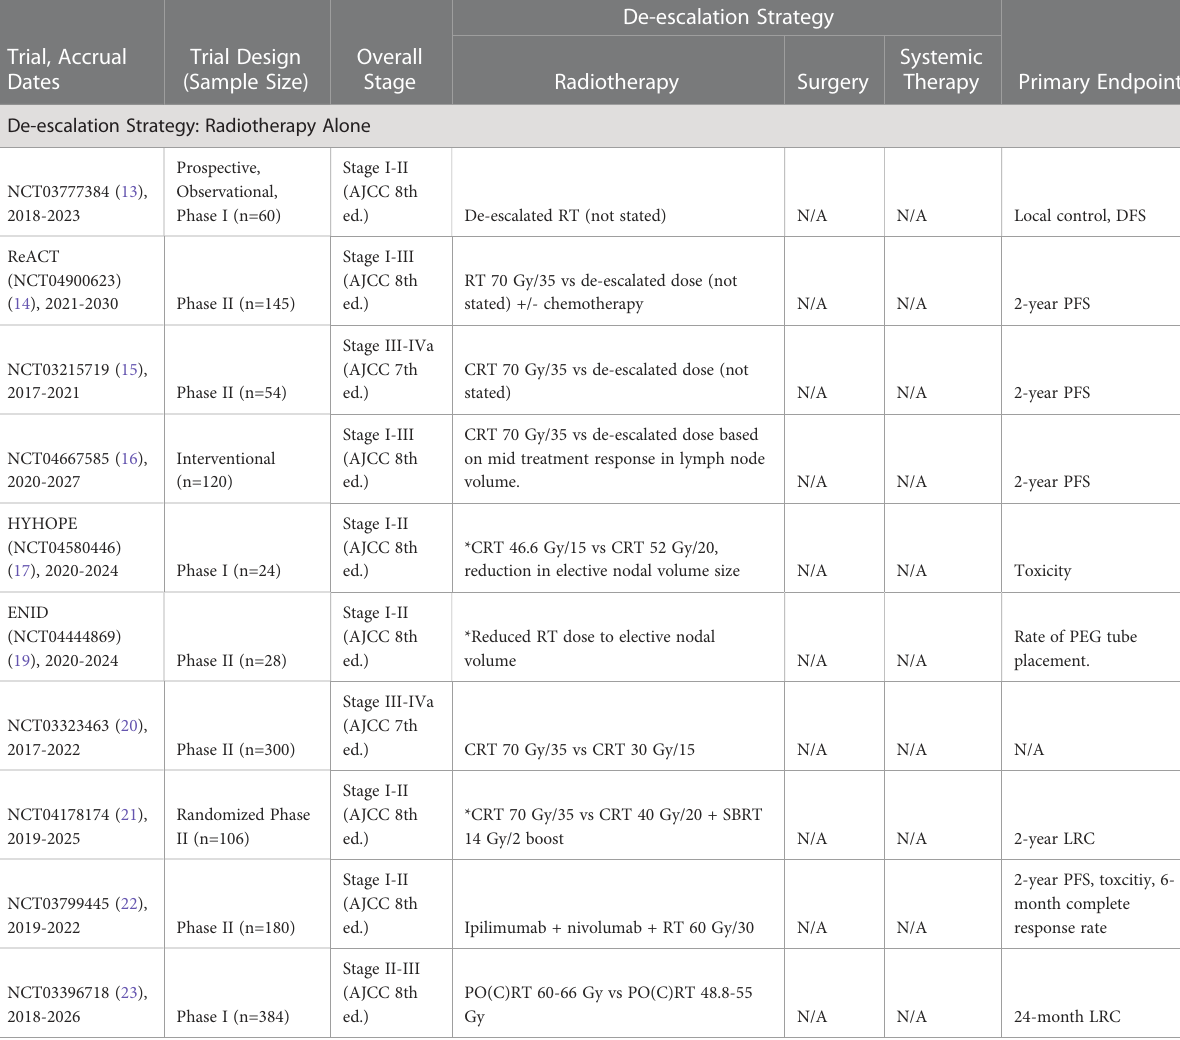
TABLE 2 Current trials examining radiotherapy de-escalation for treatment of HPV-associated OPSCC.